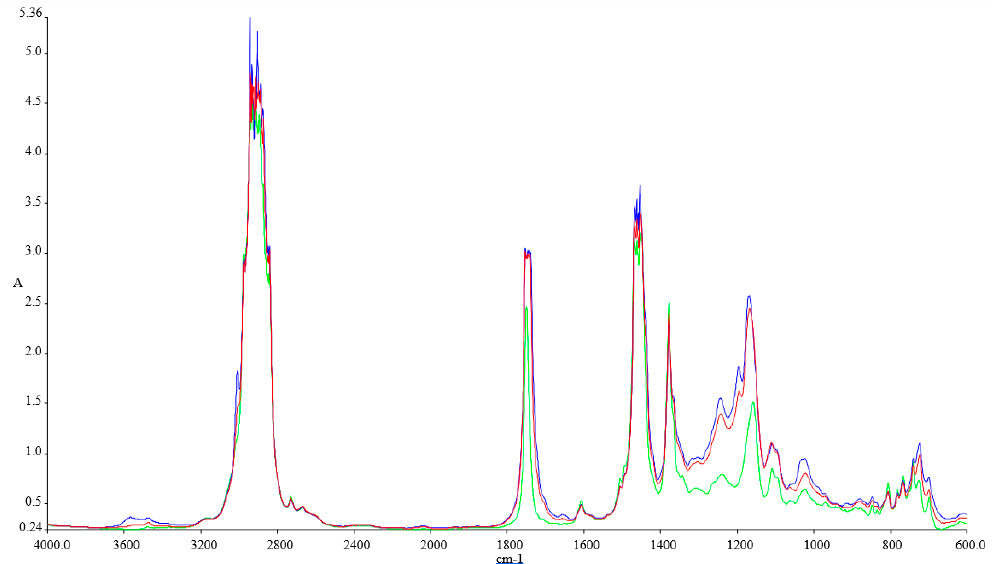
Figure 3. FTIR spectra of the tested fuel blends: Green-Ke, Blue-Ke+30%SF, and Red–Ke+30%SFP.